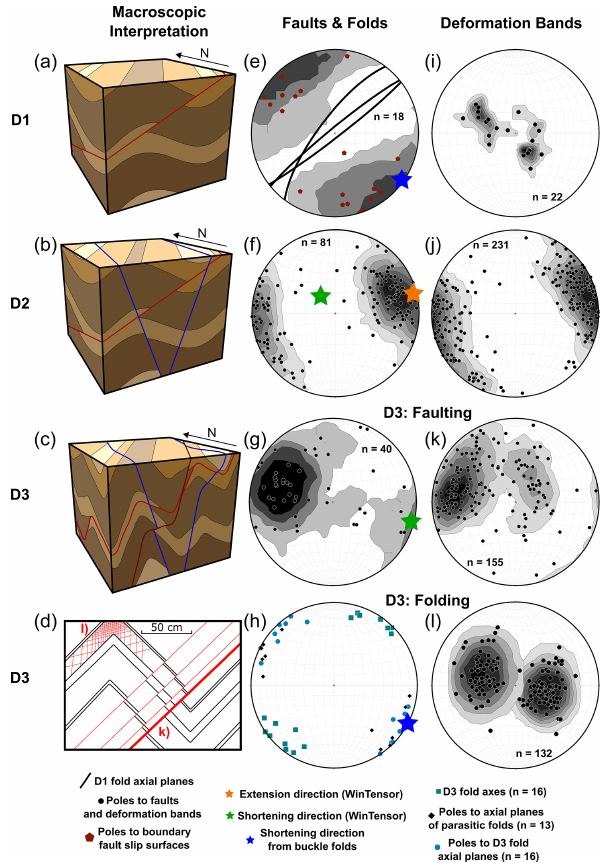
Figure 4. Tectonic evolution of the mapping area with each tectonic regime, with corresponding structural data for each phase. (a, b, c) Schematic block diagrams of each deformation phase. (d) Sketch of deformation associated with D3. During D3, two clear distribu- tions of deformation bands are observed: deformation bands asso- ciated with faults and deformation bands observed far from faults. Deformation bands observed in D2 are characterised by the same orientations as D3 DBs associated with faults (k) . (e) Schmidt net of D1 parasitic fold orientations (planes) with poles to slip surfaces observed in the damage zone of the large-scale Whakataki thrust fault. (f, g) Schmidt nets of fault orientation data from D2 and D3 deformation respectively. σ 1 is indicated by the green star. σ 3 is in- dicated by the orange star. (h) The orientation of F3 folds. When compared with F1 axial planes observed in panel (e) , the similar orientations of the principal stresses in D1 and D3 are highlighted. The blue star represents the shortening direction, estimated from the pole to the average fold axial plane. (i) Poles to D1 deforma- tion bands. (j) Poles to D2 deformation bands. (k) Poles to D3 fault damage-zone-associated deformation bands. (l) Poles to D3 deformation bands that are not located in fault damage zones. The similarity of the fault and fault-associated deformation band ori- entations indicates that they formed in the same stress field. Also, axial plane data from D3 align with D3 non-fault damage-zone- associated bands as shown in panel (l) . All deformation band and fault data are back-tilted as there is evidence of folding occurring coeval to, or later than, all events. Stereoplots were produced us- ing Stereonet 10 software (Allmendinger et al., 2011). Palaeostress analysis completed using Win-Tensor (Delvaux and Sperner,